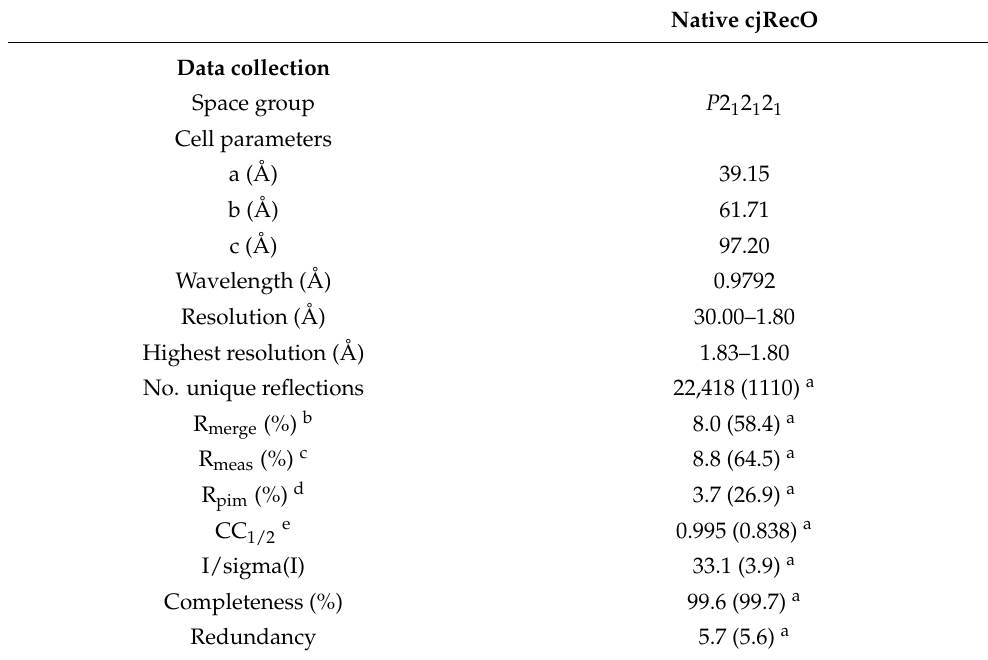
Table 2. Crystallographic statistics of the native cjRecO